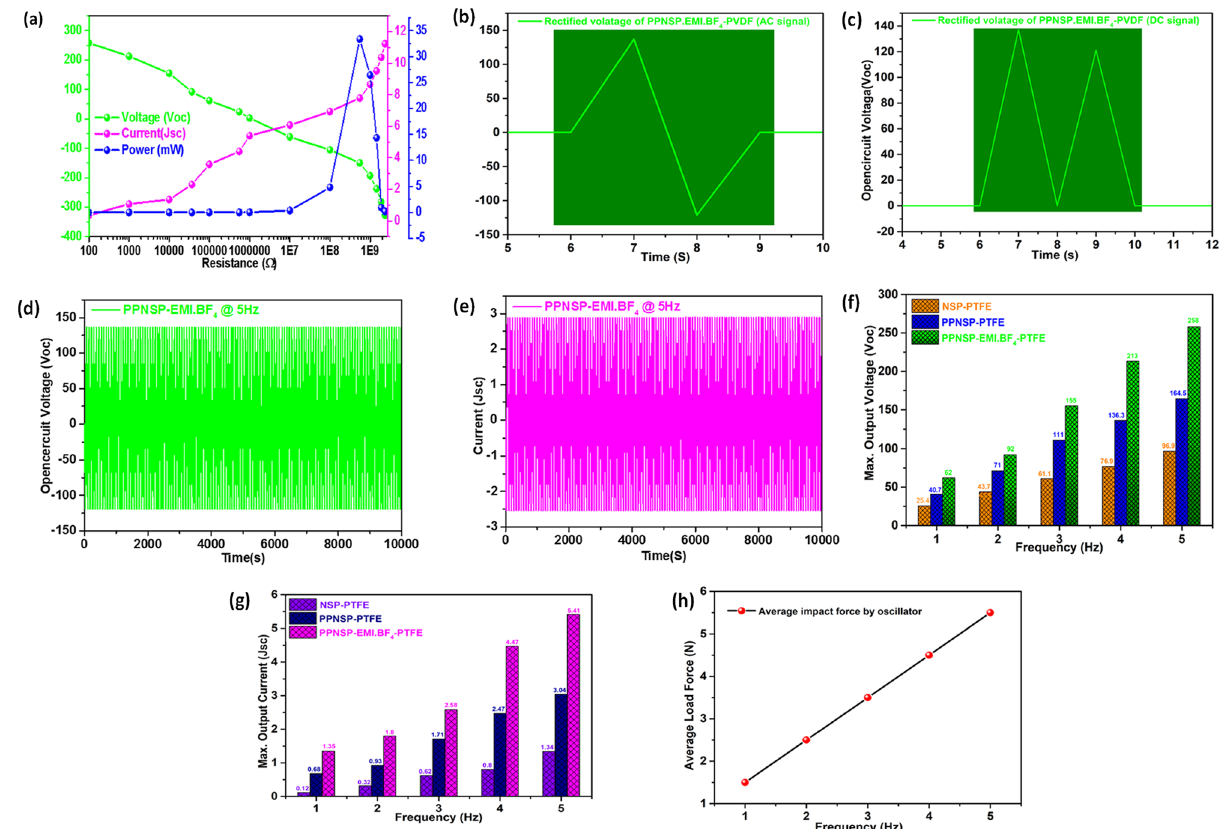
Figure 7. ( a ) Load resistance analysis and power density calculations such as open circuit voltage (Voc), short circuits current (Jsc), and power output, (mW) against external load resistances (Ω) at 5 Hz; ( b ) rectified voltage of AC signal, ( c ) DC signal; ( d and e ), stability and durability performance tests of Voc and Jsc of 10,000 cycles at 5 Hz. ( f ) Voc, ( g ) Jsc, and ( h ) Impact forces of PPNSP.EMI.BF 4 e-skin TENG at various applied